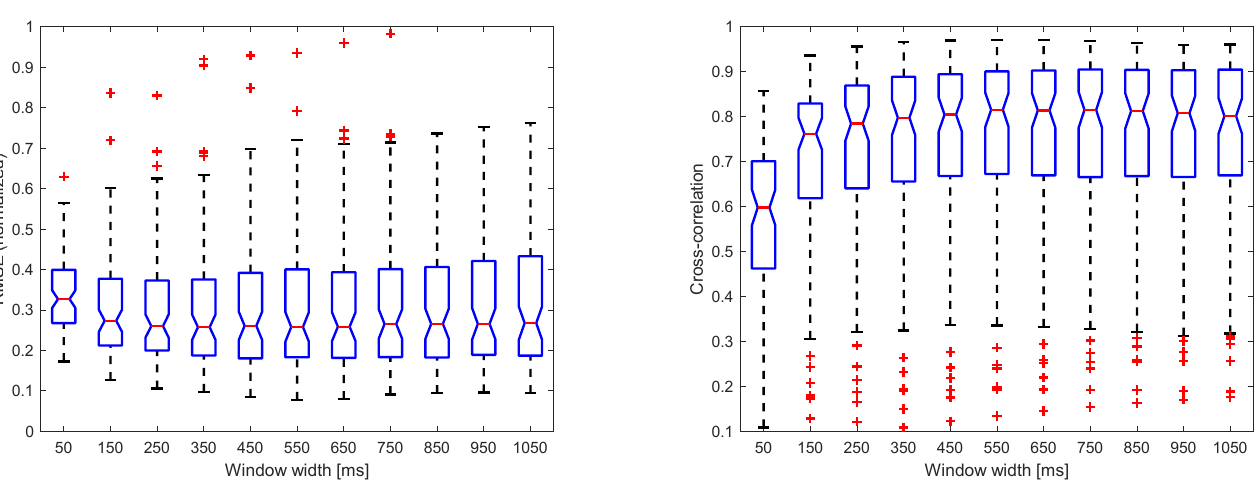
Sensors 2022 , 22 , x FOR PEER REVIEW